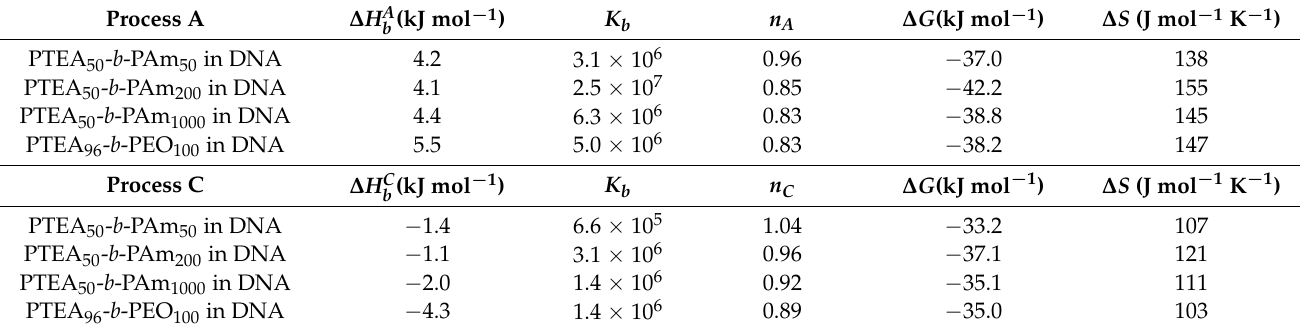
Table 2. Thermodynamic parameters obtained by fitting of the ITC curves for processes A and